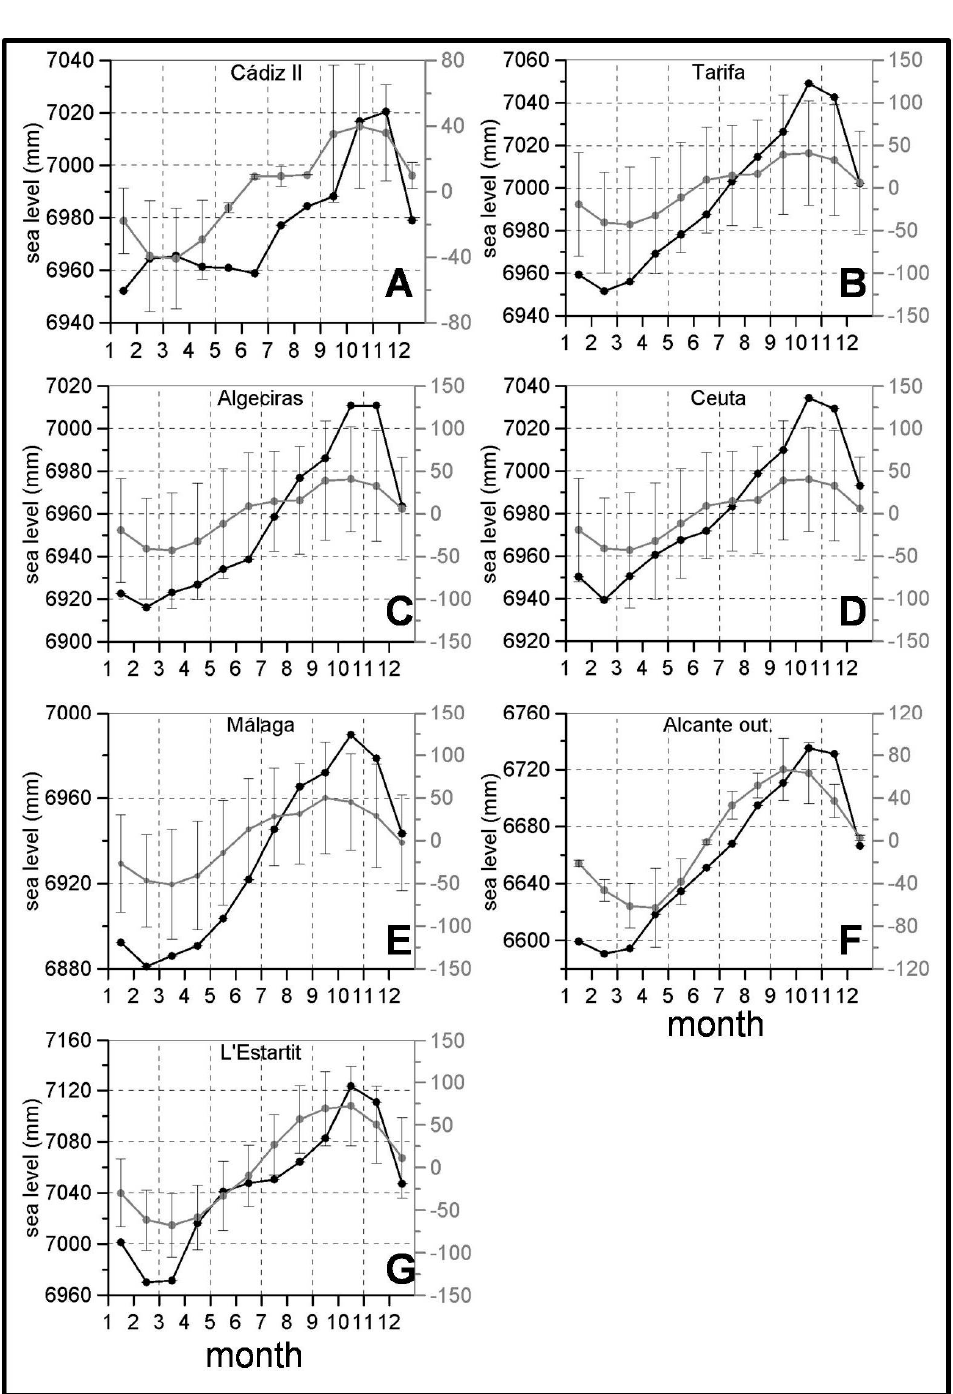
Figure 2. Sea level seasonal cycles. Black lines, seasonal cycles of observed sea level. Grey lines, seasonal cycles of the steric contribution of sea level. Vertical bars are one standard deviation. Images A to G correspond to Cádiz II, Tarifa, Algeciras, Ceuta, Málaga, Alicante (outer harbor) and L’Estartit respectively.